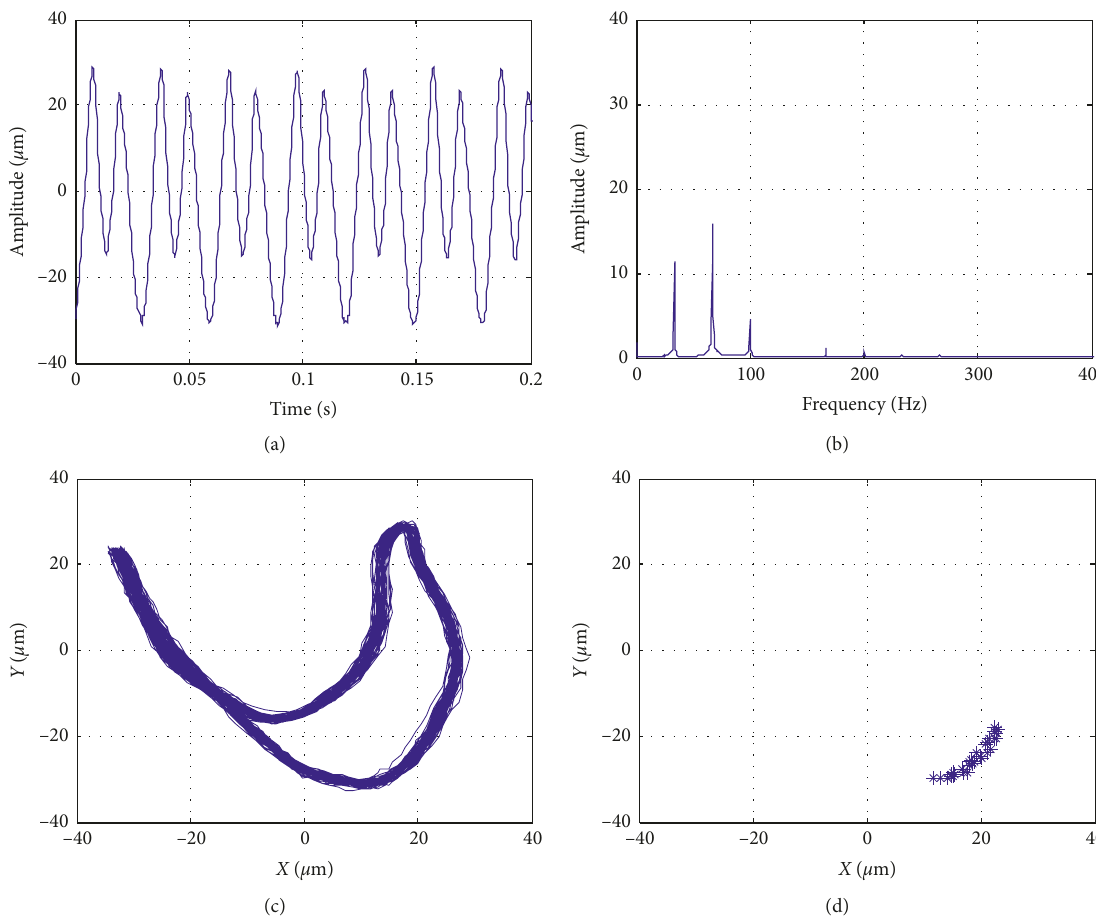
Figure 10: Local slight rubbing at 2000 r/min. (a) Time-domain waveform. (b) Spectrum graph. (c) Axis orbit. (d) Poincare